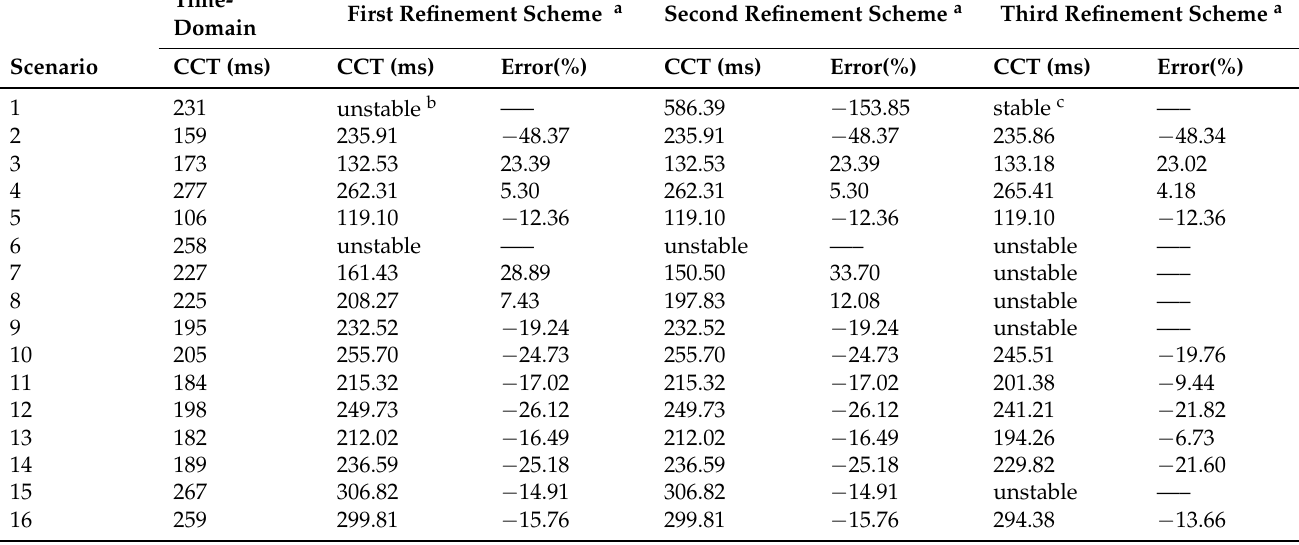
Table 4. A comparison between time-domain simulation results with the results obtained with different refined schemes for the French